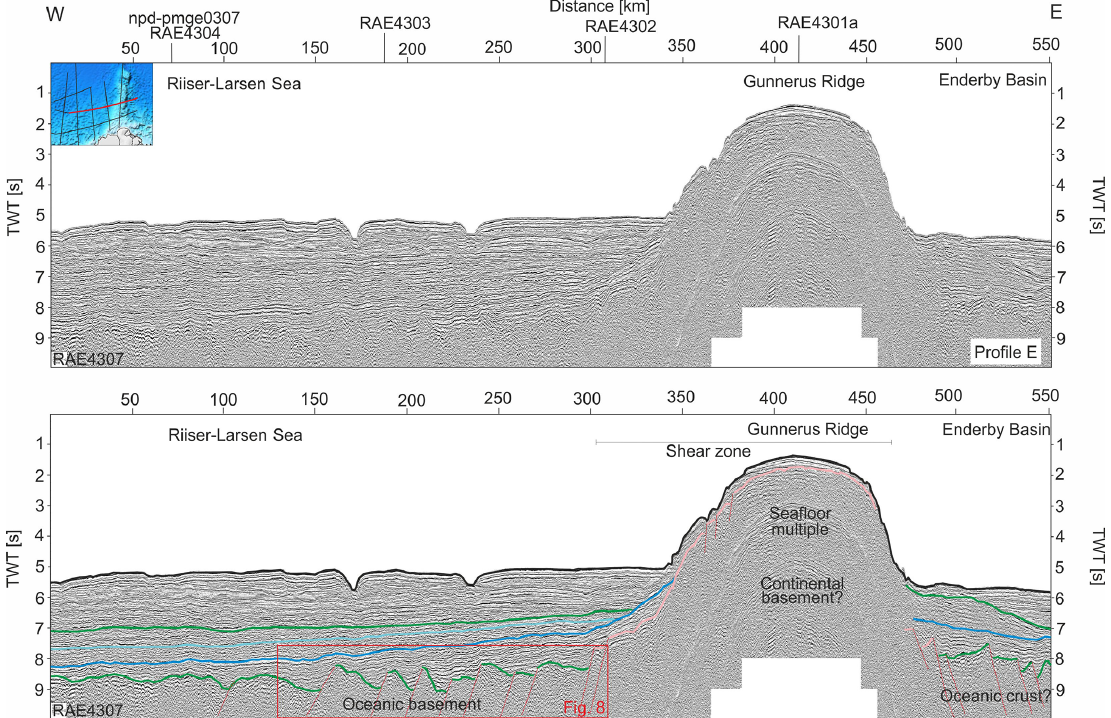
Figure 7. Stacked section of profile RAE4307 (line location in inset map and in Fig. 1). The lower panel shows the stratigraphic interpretation according to Leitchenkov et al. (2008). The profile runs from the Riiser-Larsen Sea across the Gunnerus Ridge into the Enderby Basin. The Gunnerus Ridge rises ∼ 4s (TWT) above the surrounding seafloor. The transition from continental to oceanic crust along the Gunnerus Ridge is very abrupt ( ∼ 30–40km). The oceanic crust of the Riiser-Larsen Sea is dissected by normal faults. The abundance of the faults increases significantly towards the Gunnerus